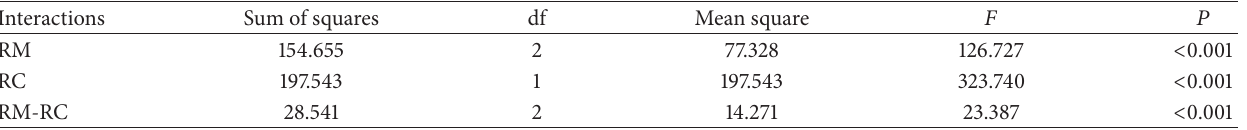
Table 4: Two-way ANOVA table for interactions of Δ𝐸 values.